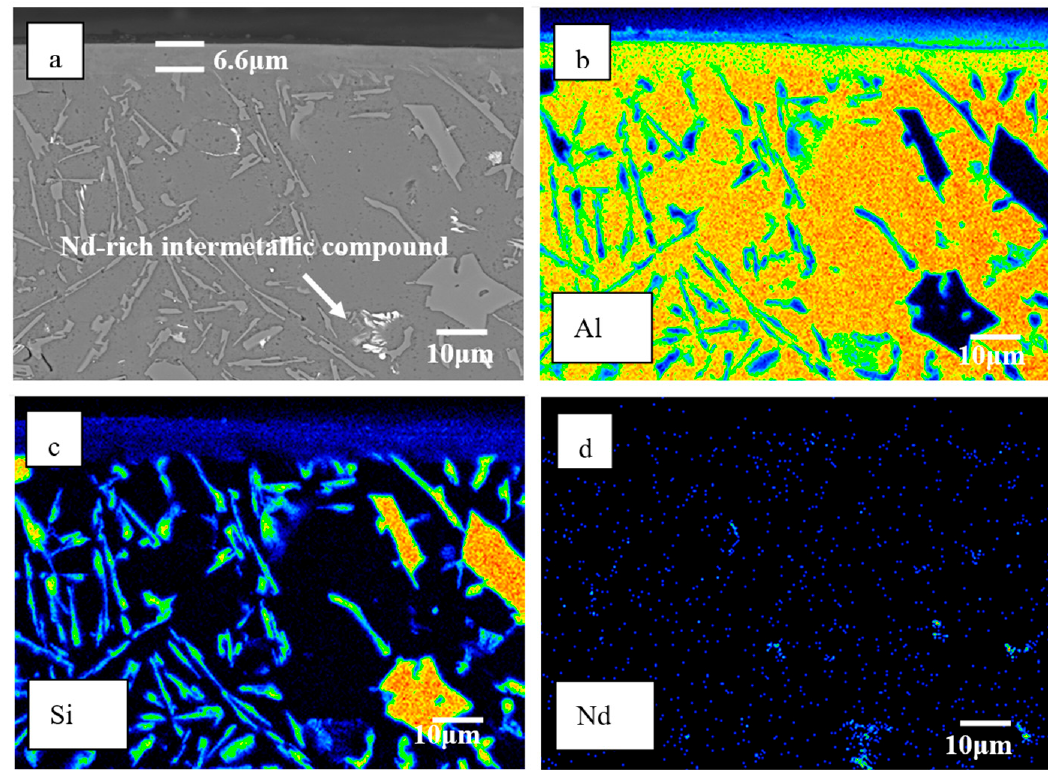
Figure 3 Figure 3. Cross-sectional composition distribution of a 25-pulsed Al–17.5Si–0.3Nd alloy ( a ) SEM image, BSE; ( b ) distribution of Al element; ( c ) distribution of Si element; ( d ) distribution of Nd element.